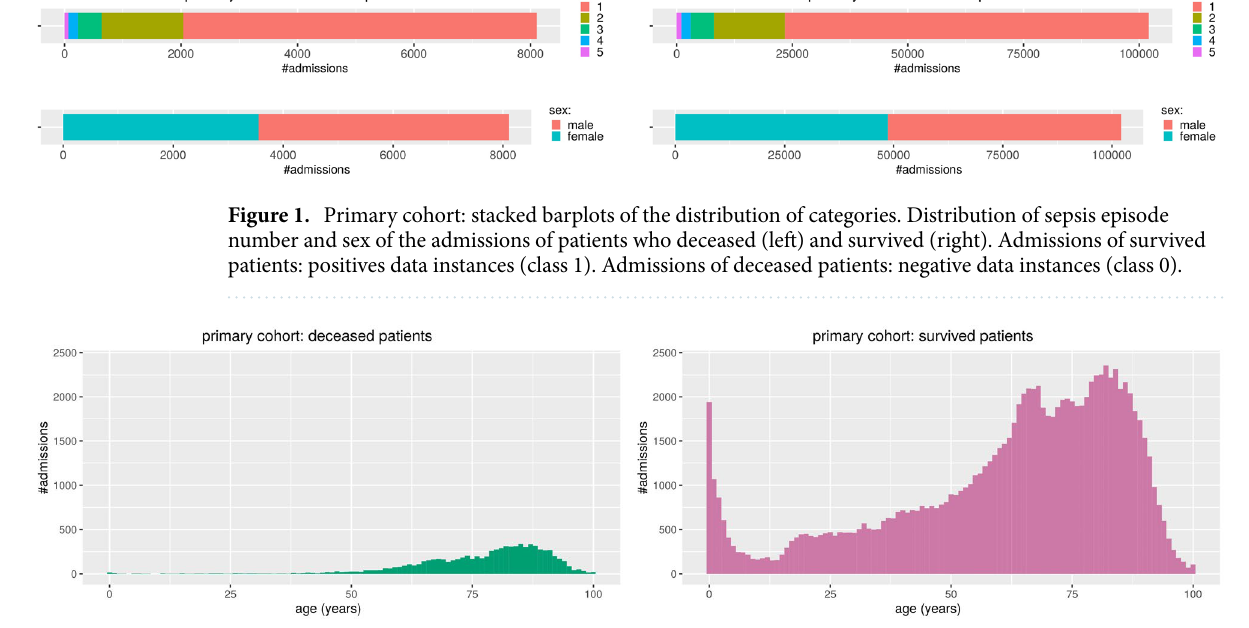
Figure 2. Primary cohort: histograms of the patients’ ages in relation with the number of admissions. On the left, the admissions of the patients who deceased. On the right, the admissions of patients who survived. Admissions of survived patients: positives data instances (class 1). Admissions of deceased patients: negative data instances (class 0).